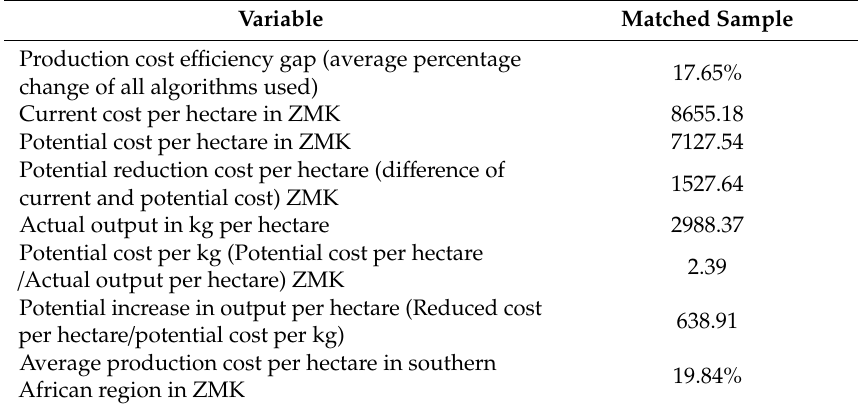
Table 5. Policy implication